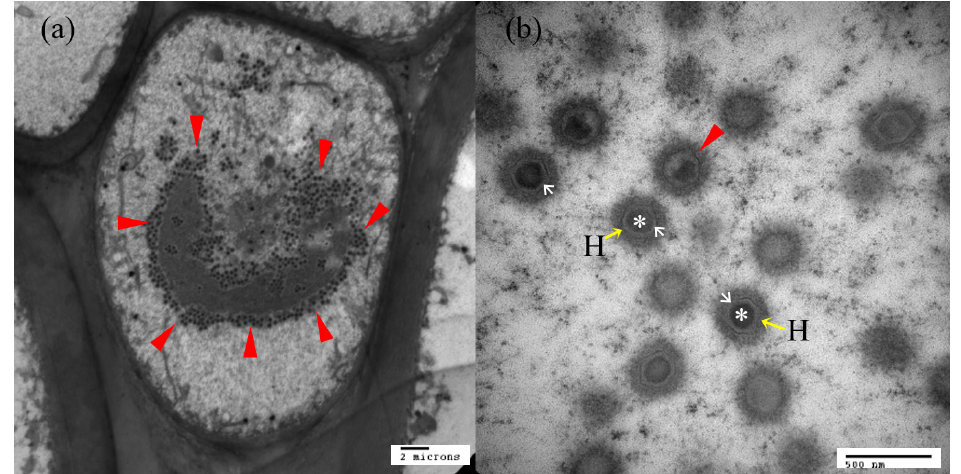
Figure 5. Transmission electron microscopy image of an ultra-thin section of a hypertrophic lym- phocystis cell. ( a ) Ultrastructure of a hypertrophic lymphocystis cell with an LCDV virus particle, ( b ) LCDV virus. Red arrow: virus particle; H with yellow arrow: hexagonal profile protein shell; White arrow: inner membrane; *: central DNA core.